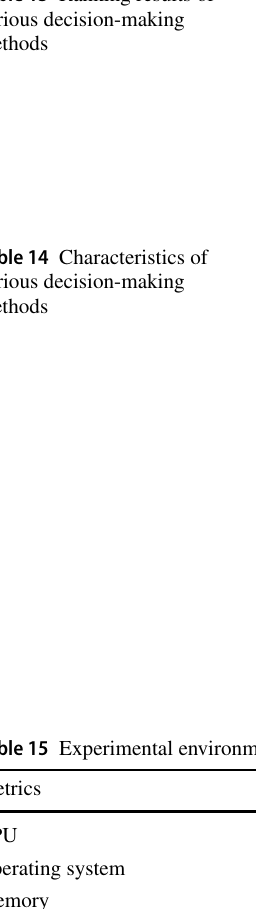
Table 13 Ranking results of various decision-making methods